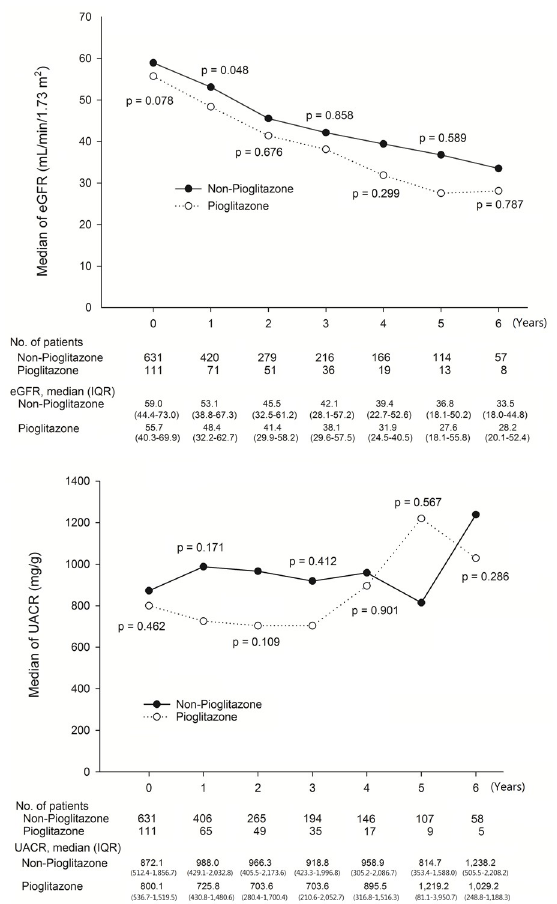
Fig 3. Association between eGFR and UACR between Pioglitazone and non- Pioglitazone users.